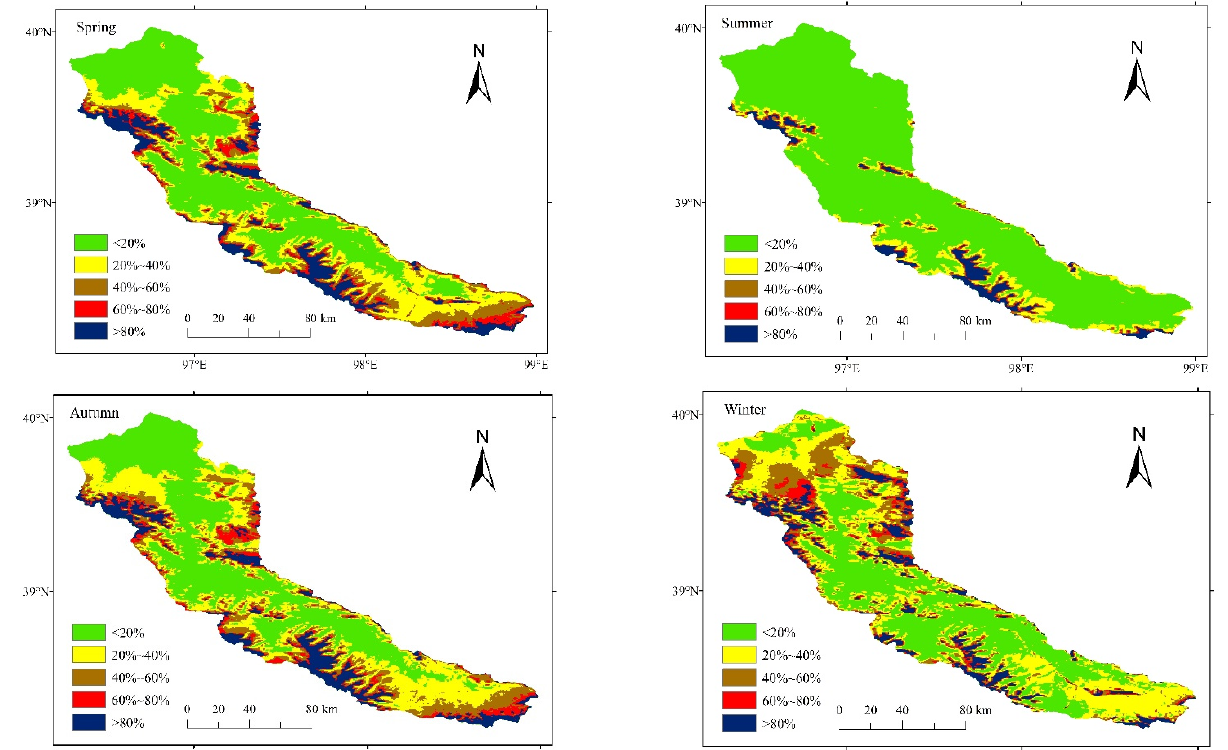
Figure 2. Spatial distribution of snow cover frequency in the upper reaches of the Shule River in different seasons.